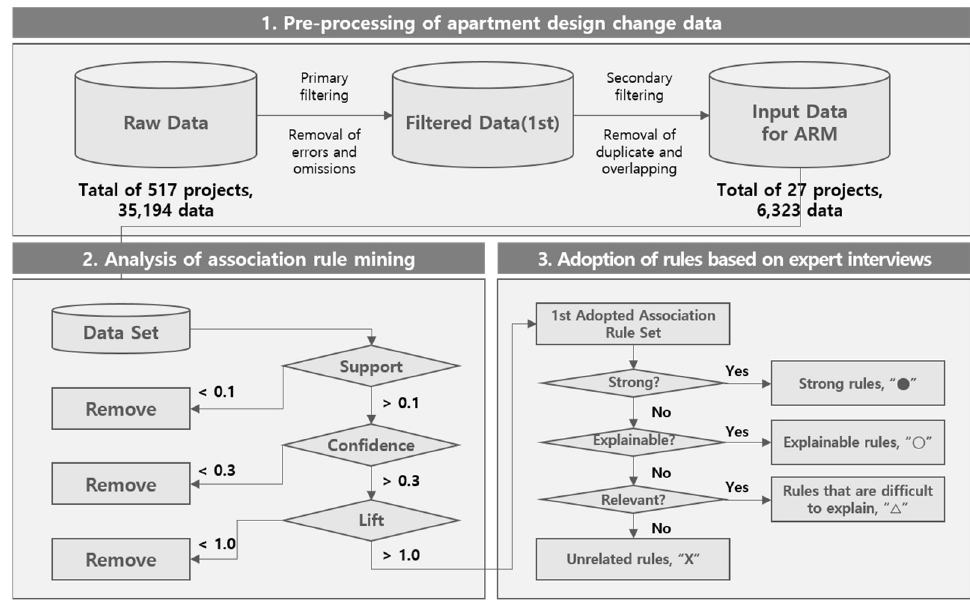
Figure 2. Design of ARM model.